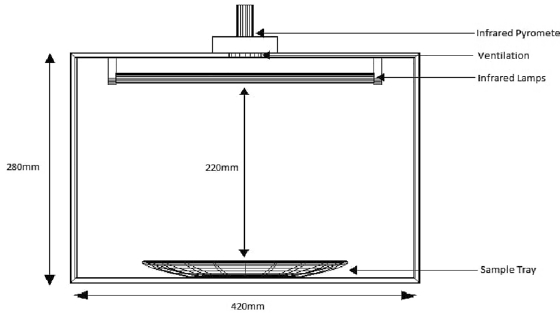
Figure 1. Schematic diagram of the infrared heating system.